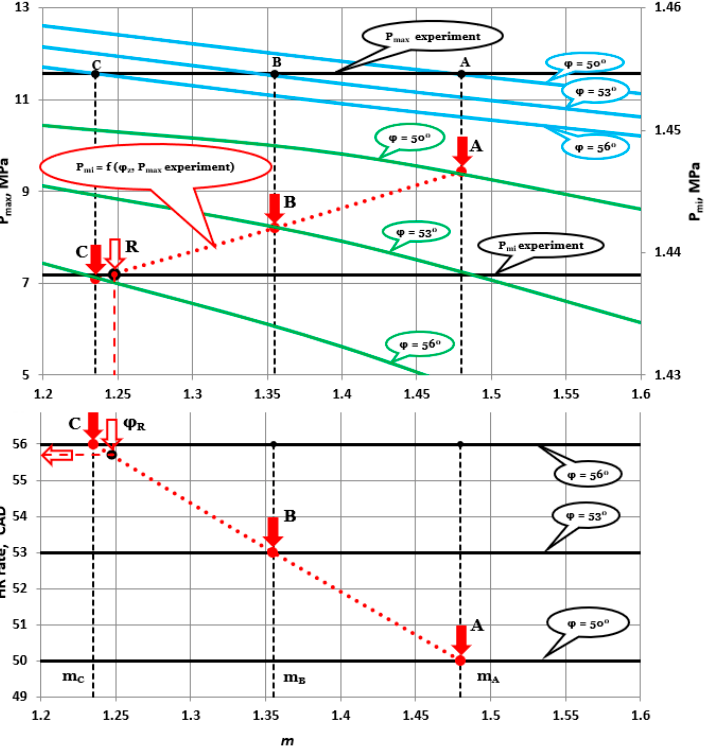
Figure 4. Graphical method for determining m and φ z by Bulaty–Glanzman method (based on P max and P mi ).